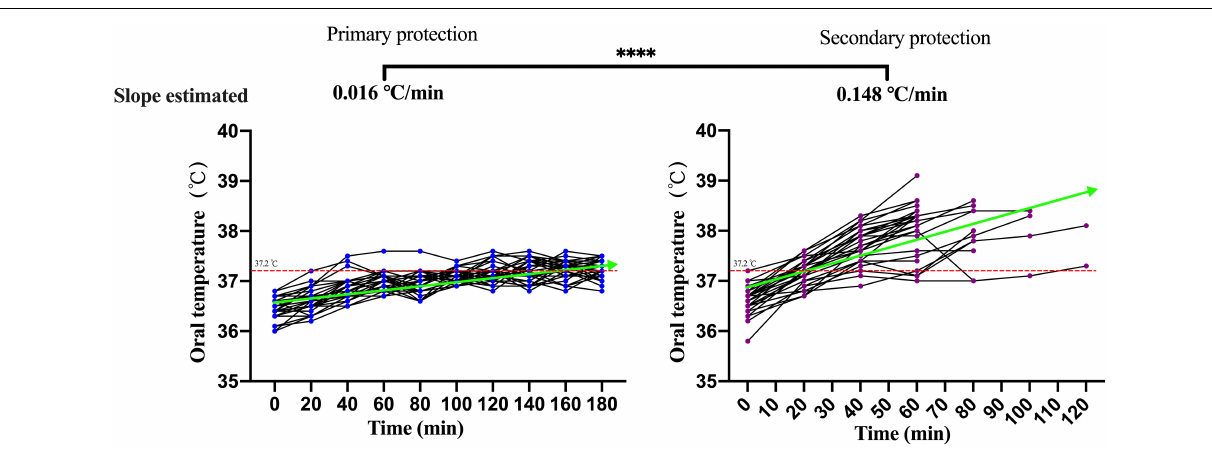
rate, and blood oxygen saturation for the primary PPE and secondary PPE groups during the trial duration using generalized estimating equations (GEE). The value of p < 0.05 is considered statistically